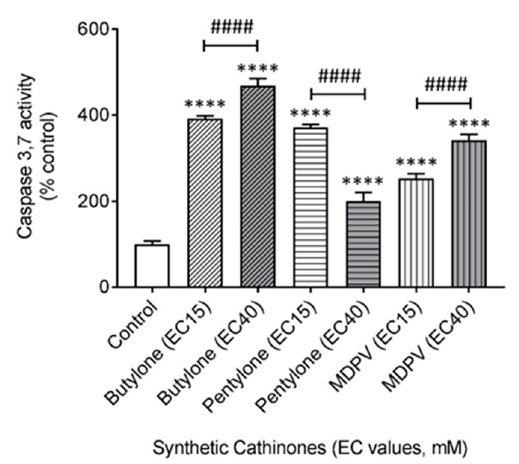
Figure 7. Effect elicited by EC 15 and EC 40 for butylone, pentylone, and MDPV in the activation of caspase 3 and 7 after 24 h of treatment. Data are Mean ± SD obtained from four independent experiments normalized to the % confluence of cells. #### p < 0.0001 vs. EC 15 . Different to the control; **** p < 0.0001.